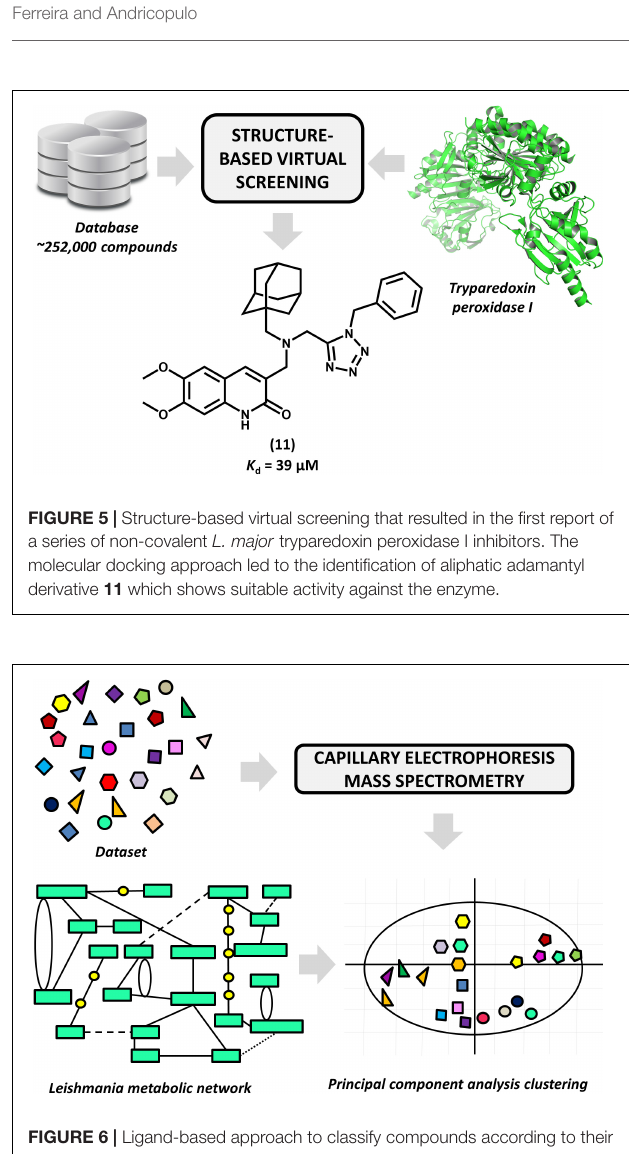
FIGURE 6 | Ligand-based approach to classify compounds according to their mechanism of action. The effects of the dataset compounds on Leishmania metabolism were analyzed by capillary electrophoresis–mass spectrometry, and the data were used in a principal component analysis (PCA). The PCA was able to cluster compounds according to the perturbation they caused in the parasite’s metabolic